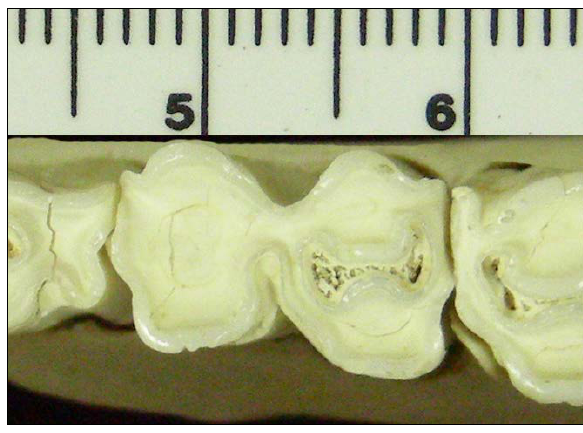
Figure 2: NMB 7440, a mandibular first molar that was correctly classified as an Alcelaphini, Damaliscus dorcas (blesbok).